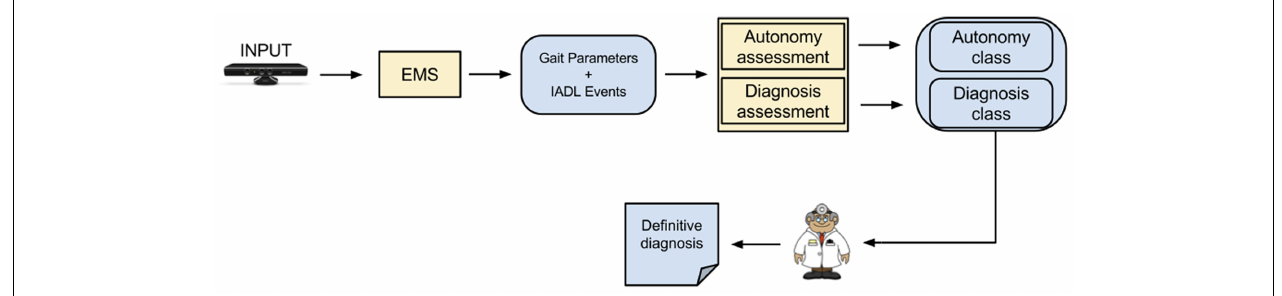
people detection, people tracking, gait analysis and event recognition. The main outcome is based on the fusion of “Gait Parameters” and “Instrumental Activities